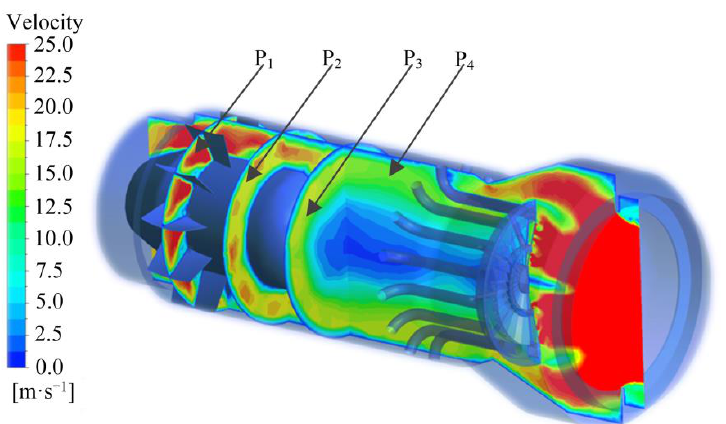
Figure 5. The velocity contours of different section. (P 1 : x = − 3.8 m; P 2 : x = − 3.5 m; P 3 : x = − 3.2 m; P 4 : z = 0).